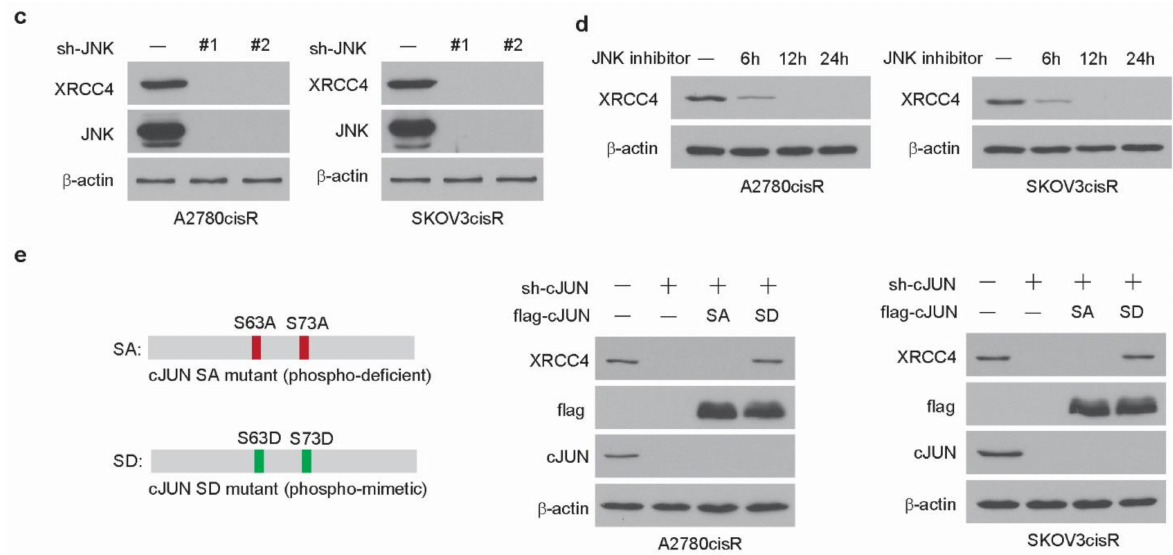
Figure 6. JNK-cJUN axis activated by cisplatin promotes XRCC4 expression in the cisplatin-resistant ovarian cancer cells ( a ) Localization of cJUN and JNK in cells treated with cisplatin. Treatment: cisplatin (5 µ g/mL A2780cisR and 2 µ g/mL SKOV3cisR) for 48 h. β -Actin and PARP were used as cytoplasmic and nuclear markers, respectively. C, cytosol, N, nucleus. ( b , c ) Detection of the level of XRCC4 by Western blot in A2780cisR and SKOV3cisR cells with/without the knockdown of cJUN ( b ) and JNK ( c ), respectively. Cells were treated with cisplatin. Treatment: cisplatin (5 µ g/mL A2780cisR and 2 µ g/mL SKOV3cisR) for 48 h. ( d ) Detection of the level of XRCC4 by Western blot in A2780cisR and SKOV3cisR cells treated with JNK inhibitor in a time-dependent manner. Cells were cotreated with cisplatin. Treatment: cisplatin (5 µ g/mL A2780cisR and 2 µ g/mL SKOV3cisR). ( e ) Left: Schematic illustration of cJUN SA (S63A/S73A) or SD (S63D/S73D) overexpression plasmid. Right: detection of the level of XRCC4 by Western blot in A2780cisR and SKOV3cisR cells with endogenous cJUN removed and rescued by cJUN SA or cJUN SA mutants. Data are representative of 2 ( a ), 3 ( b ), 2 ( c ), 3 ( d ), and 2 ( e ) independent biological